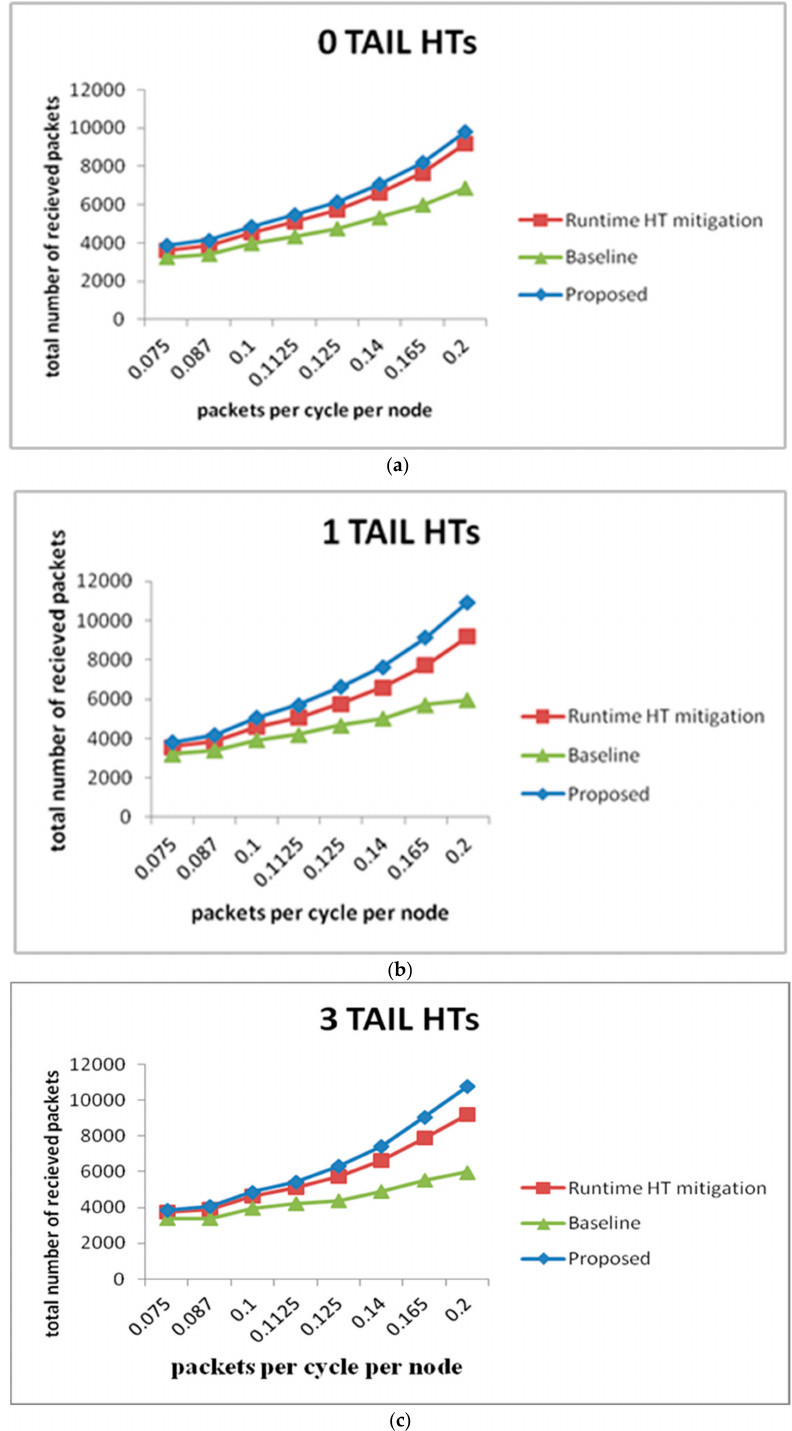
Figure 11. ( a ) No tail HT. ( b ) One tail HT. ( c ) Three tail